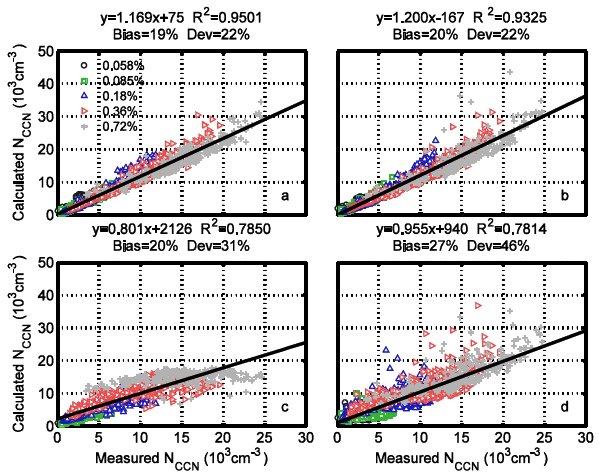
Fig. 9. Closure between Measured CCN Number Concen- tration and the CCN Number Concentration Calculated from Aerosol Number Size Distribution (SD) and Size-resolved Acti- vation Ratio (SRAR) for Different Supersaturations (a) : Real- time SD and SRAR; (b) : Real-time SD and Averaged SRAR; (c) : Average N CN (keep NASD) and Real-time SRAR; (d) : Av- erage NASD (keep N CN ) and Real-time SRAR. There are 1527 pairs of data in each panel. The title of each panel shows the fitted function, correlation coefficient, average relative bias (Bias=( N CCN - cal − N CCN - meas )/ N CCN - meas ) and average relative deviation (Dev= | N CCN - cal − N CCN - meas | / N CCN - meas